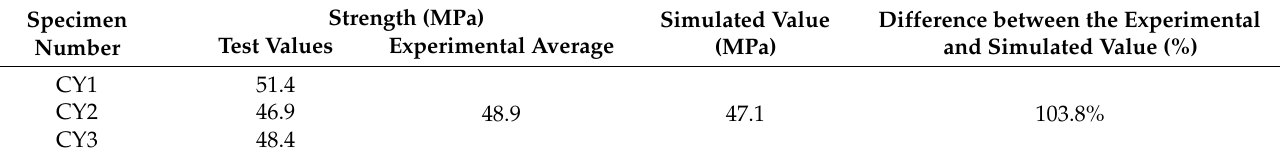
Table 22. Comparative analysis of Y-axial compression testing and numerical simulation.